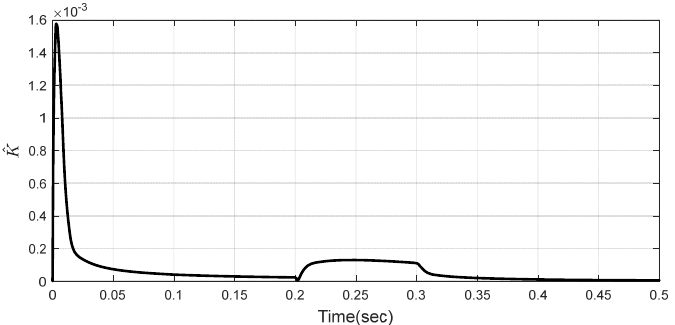
Figure 35. Adaptation gain.